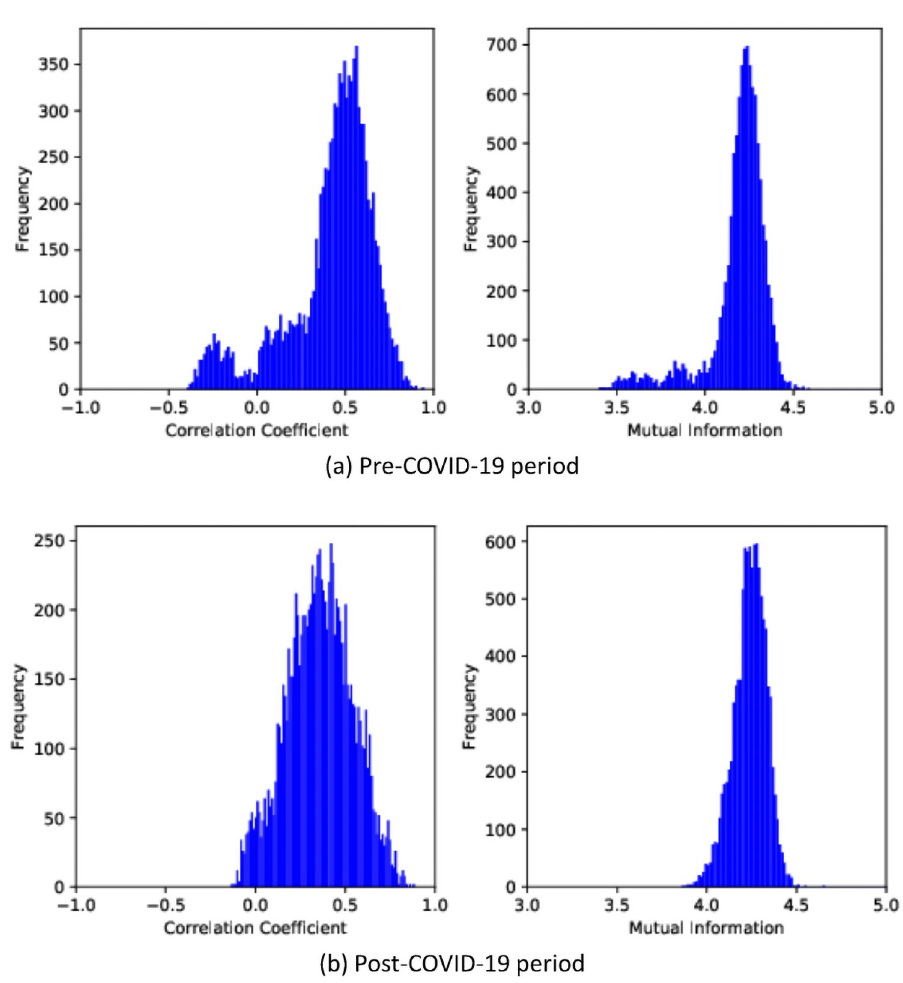
Fig 3. Histogram of correlation coefficient and mutual information in pre- and post-COVID-19 periods. (a) Frequency distribution of two methods in 2019. (b) Frequency distribution of two methods in 2020.